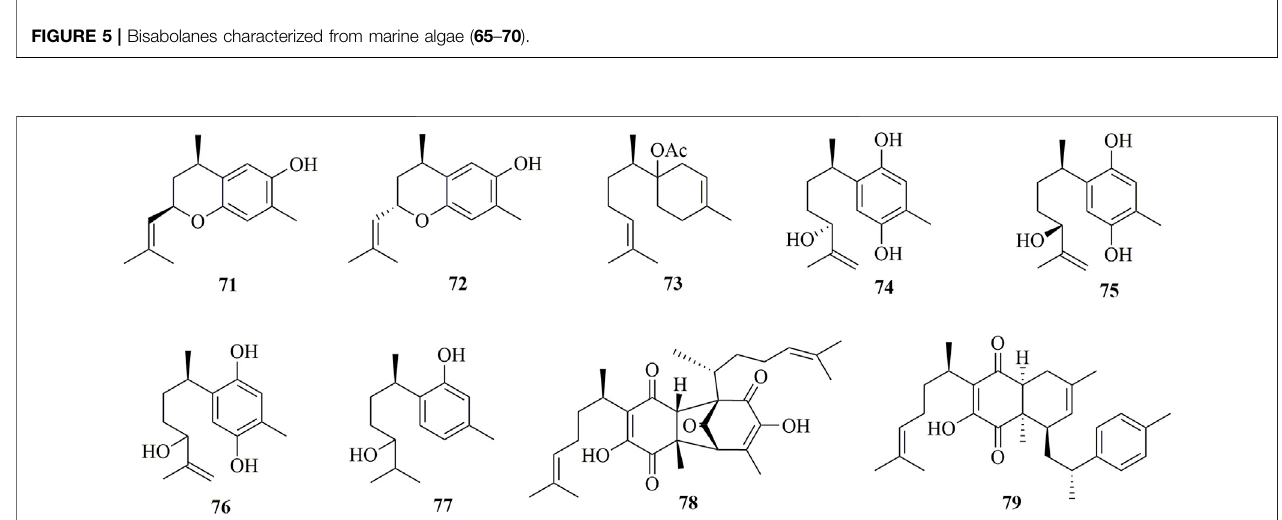
FIGURE 6 | Bisabolanes characterized from soft corals ( 71 – 79 ).